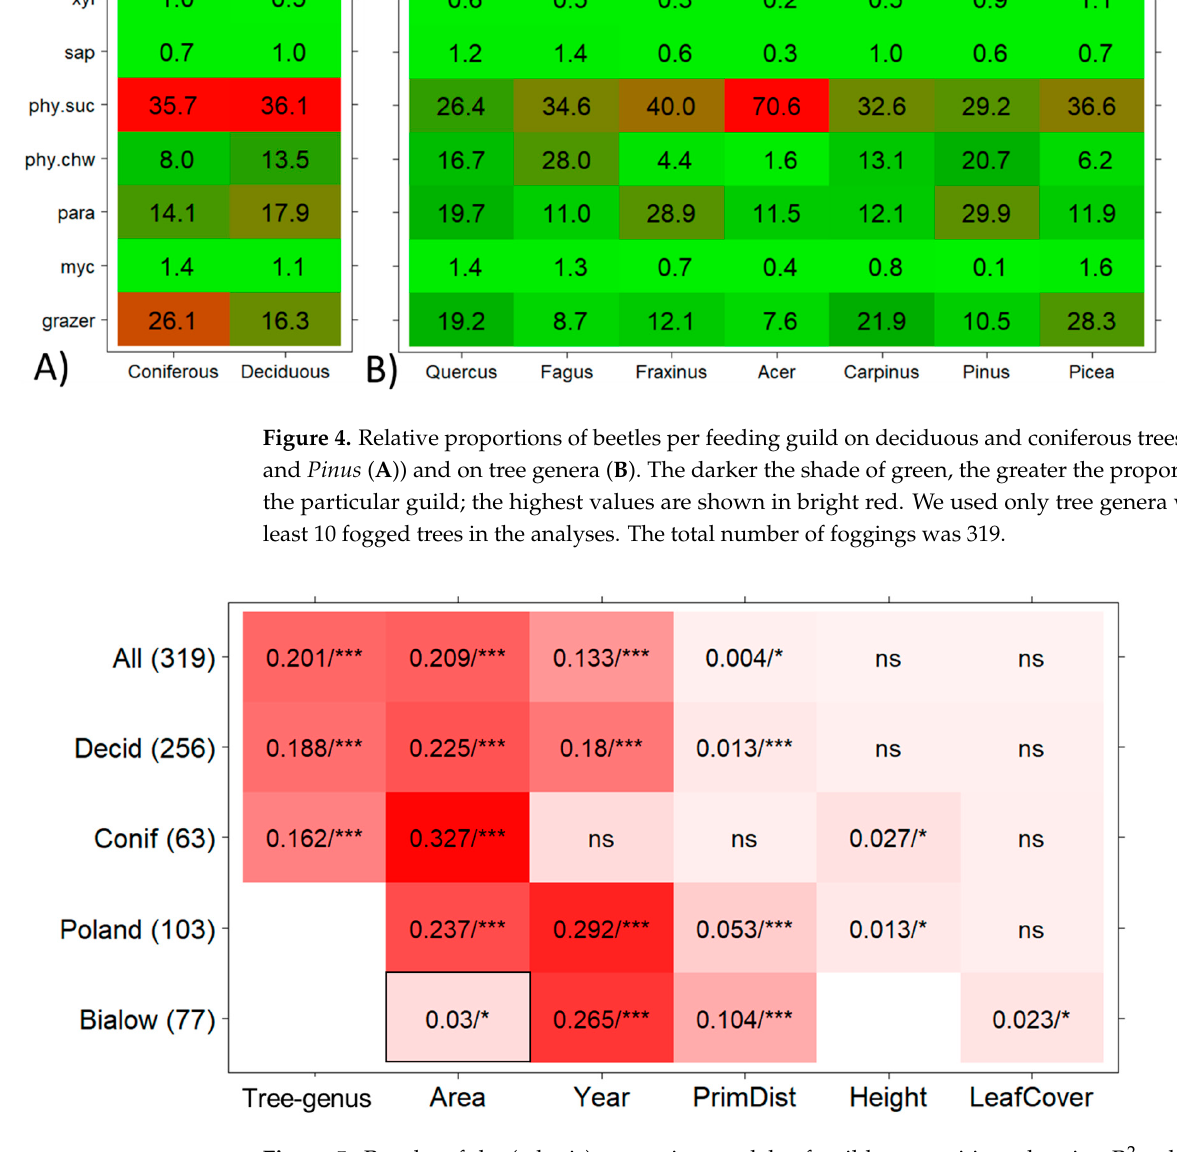
Figure 5. Results of the (adonis) regression models of guild composition, showing R 2 values for significant coefficients based on different study strata ( y -axis), with the number of fogged trees in brackets. On the x -axis, the R 2 with the associated significance level is shown. Dropped factors are indicated by white boxes, while non-significant factors are depicted with “ns”. For the condensed Bialowieza model (Bialow) only, we used the coordinates of each sampled tree as numerical factors in the model, in which only NorthSouth was weakly significant (R 2 = 0.03 framed box for Area). The factor Height (tree height) was dropped in this model, due to strong collinearity with the factor Management. p < 0.05 (*), p < 0.001 (***).